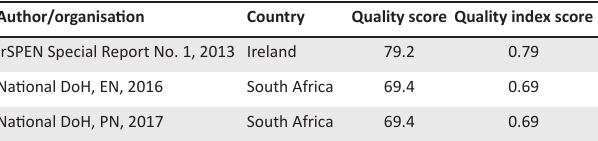
TABLE 5b: Summary of quality assessment report of included studies from grey literature